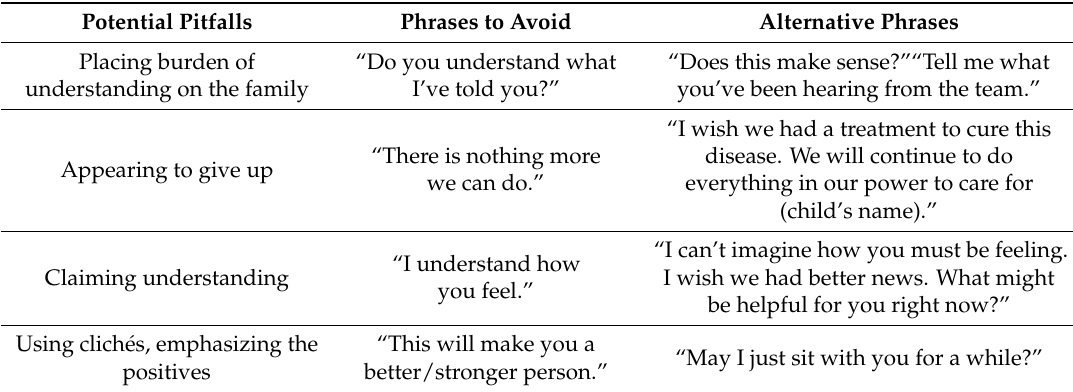
Table 6. Communication in the context of progressive or refractory